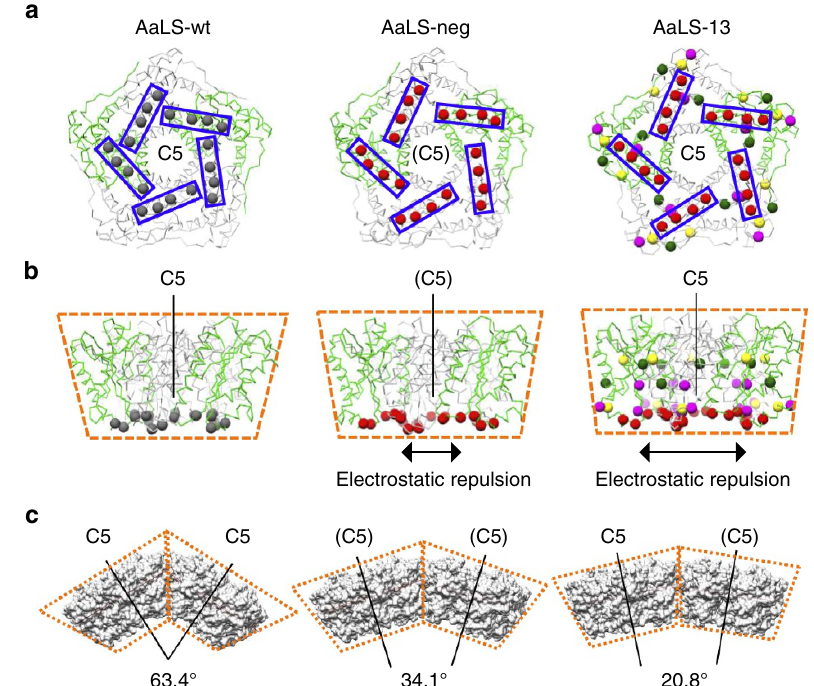
Figure 6 | Geometrical rearrangements triggered by tilted monomers. ( a , b ) Representative pentamers of AaLS-wt, AaLS-neg and AaLS-13. Two of the five monomers for each structure are shown in green and the rest in grey. Views around the (pseudo) five-fold rotational symmetry axes ( a ) and the corresponding side views parallel to the axes ( b ) are shown. Residues 83, 86, 120 and 123, which were mutated to glutamates by design, are shown as red spheres and boxed. For AaLS-13, residues 28, 52, 112, 115, 118, 127 and 131, which were mutated during directed evolution, are shown as coloured spheres. Red and magenta spheres indicate the negatively charged residues that were introduced. The wedge-like shapes of the pentamers are schematically highlighted by dotted lines. ( c ) Representative orientation of two adjacent pentamers in AaLS-wt, AaLS-neg and AaLS-13, respectively. Angles between the adjacent local (pseudo) five-fold axes are